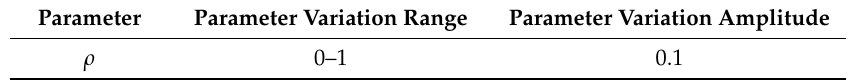
Table 2. Parameters of Scenario 1.